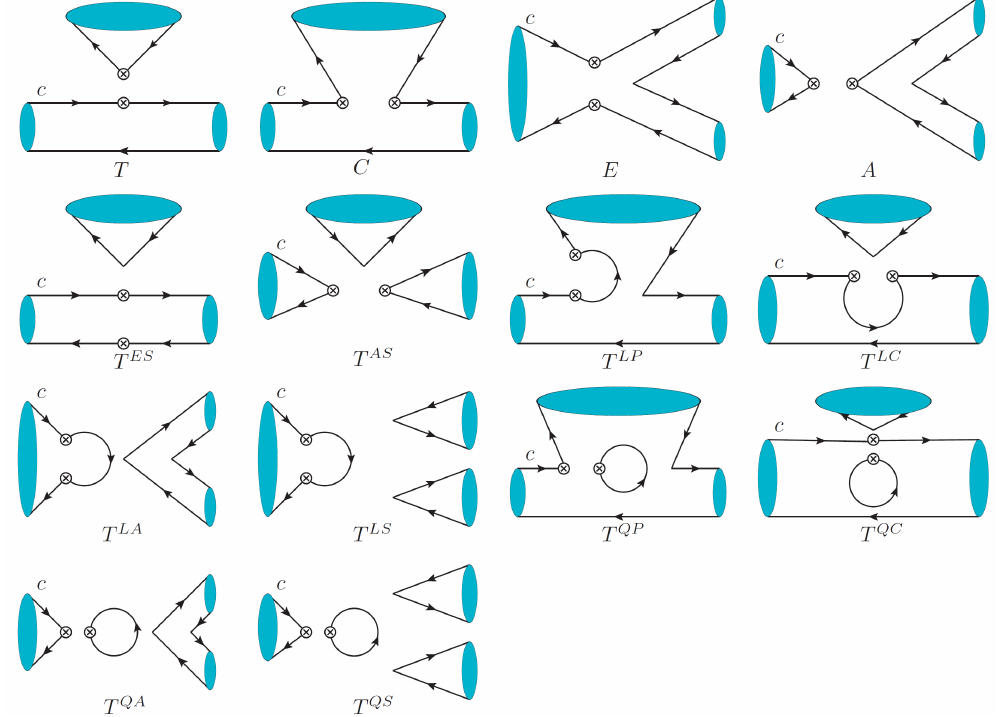
Figure 3 . Topological diagrams in the D → PP